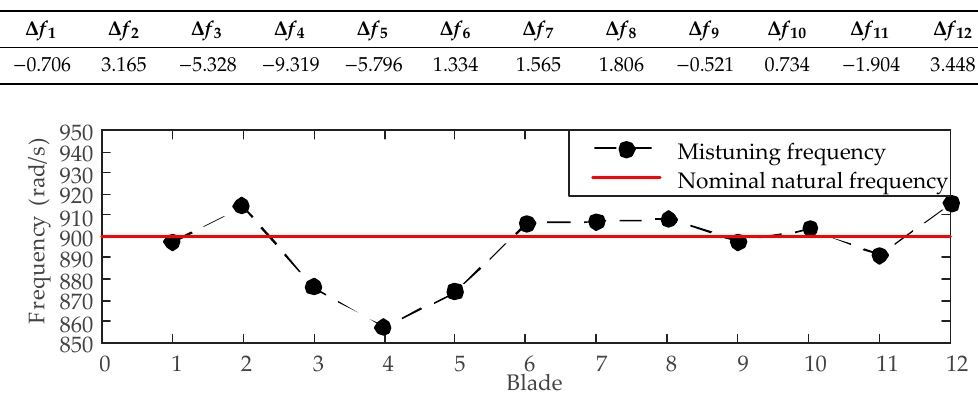
Table 1. The distribution of the mistuning coefficient Δ f i (%).